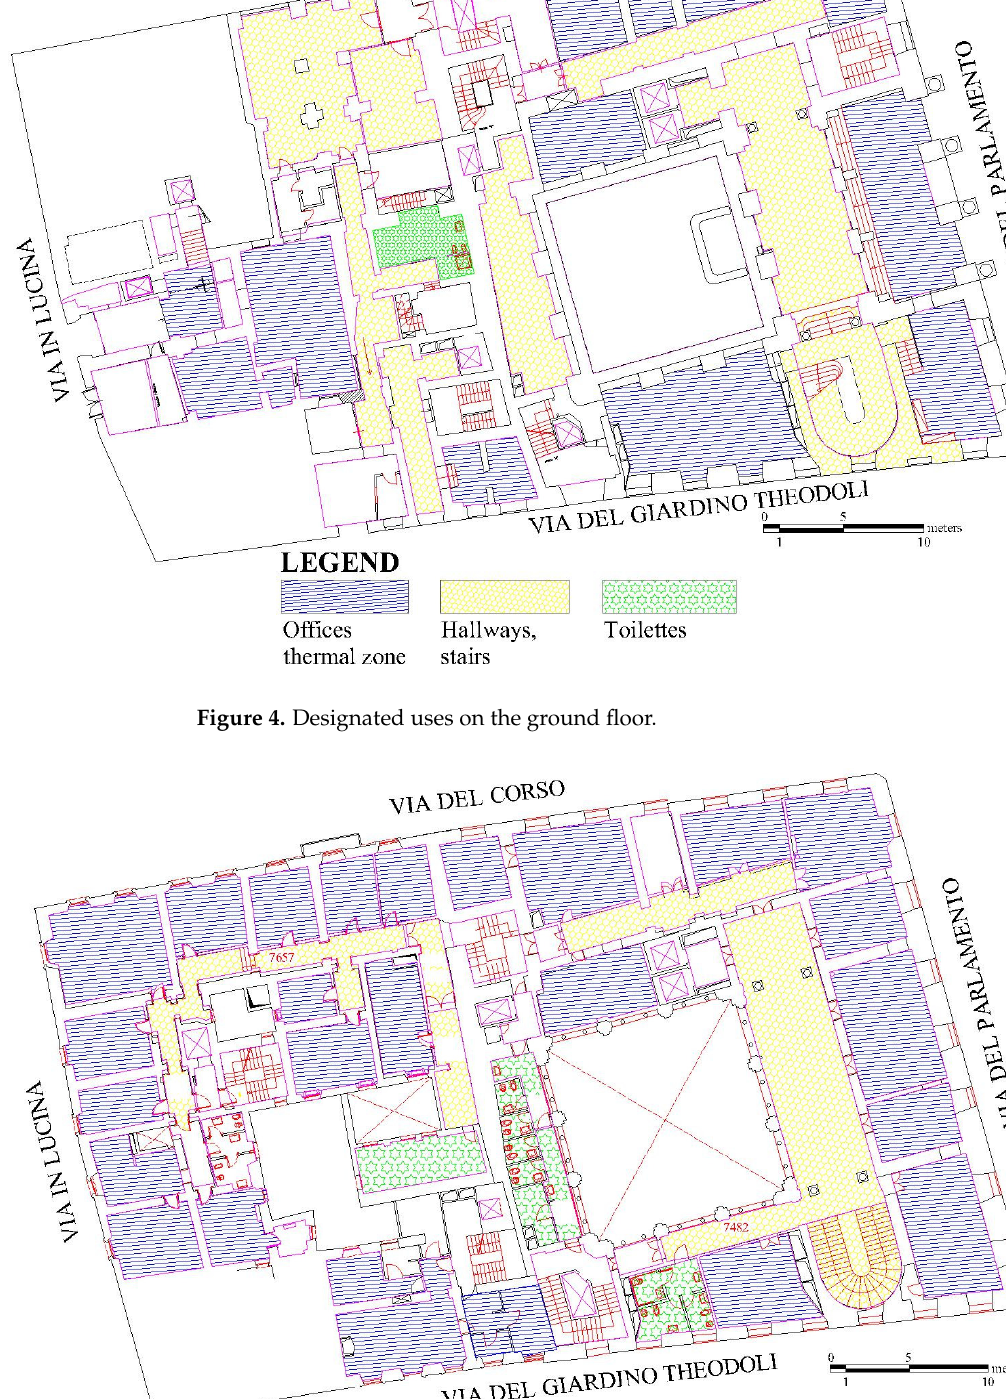
Figure 5. Designated uses on the first floor.